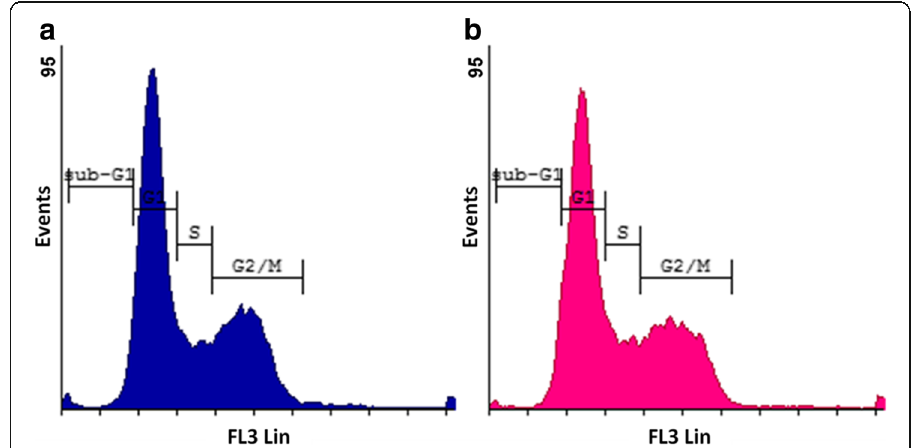
Fig. 7 Histograms of the cell cycle distribution of HeLa cells. Cells propagated in growth medium ( a ) and vehicle-control cells ( b ) showed normal cell cycle profiles after 24